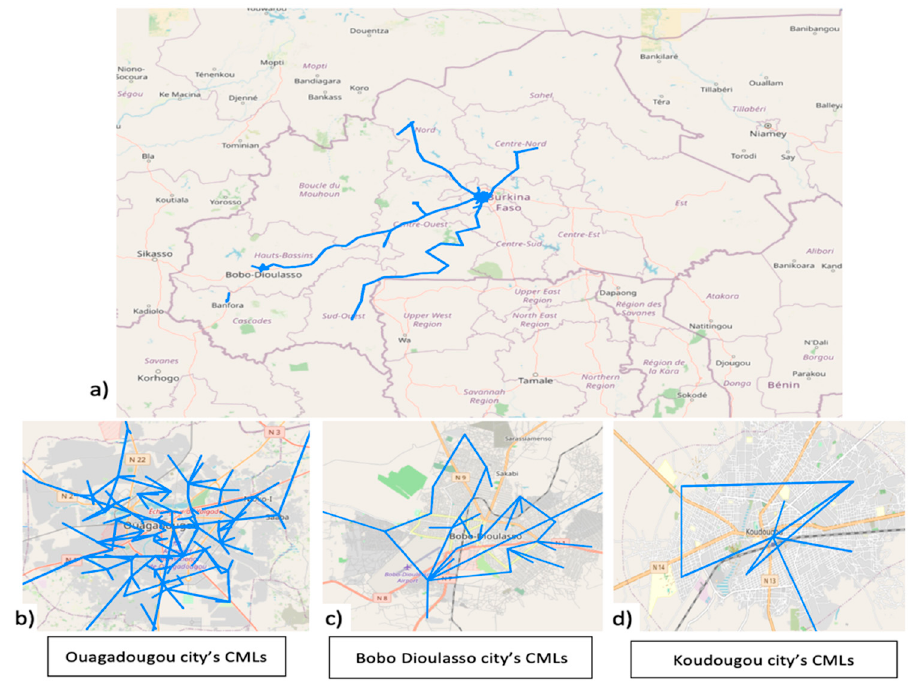
Figure 4. Map of the CMLs of the Telecel Faso’s network in Burkina Faso ( a ) connected to the acquisition system, and zoom for the cities of Ouagadougou ( b ), Bobo-Dioulasso ( c ), and Koudougou ( d ).